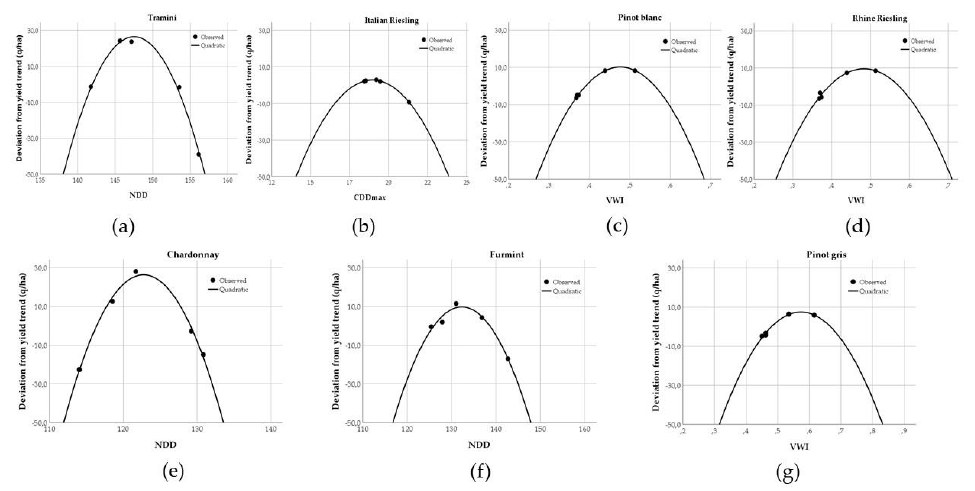
Figure 10. Functions of the best regression fit for white wine grape varieties for 2017 – 2021 in the Hungarian wine regions. ( a ) refers to the Tramini, ( b ) refers to the Italian Riesling, ( c ) refers to the Pinot blanc, ( d ) refers to the Rhine Riesling, ( e ) refers to the Chardonnay, ( f ) refers to the Furmint, ( g ) refers to the Pinot Gris variety.